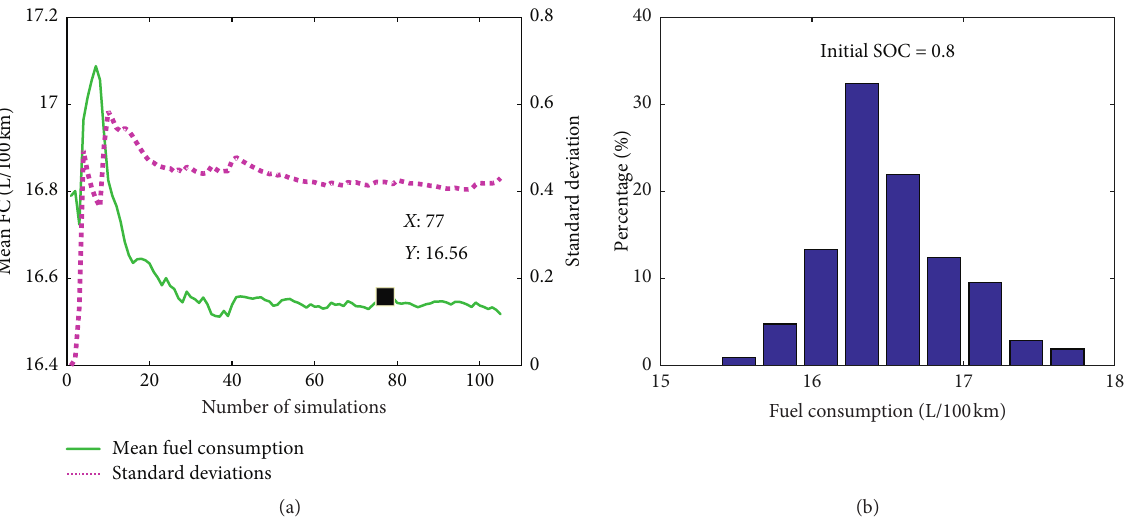
Figure 25: Mean FC, std. dev., and FC distribution for the measured data (initial SOC � 0.8). (a) Mean FC and std. dev and (b) distribution of the FC.